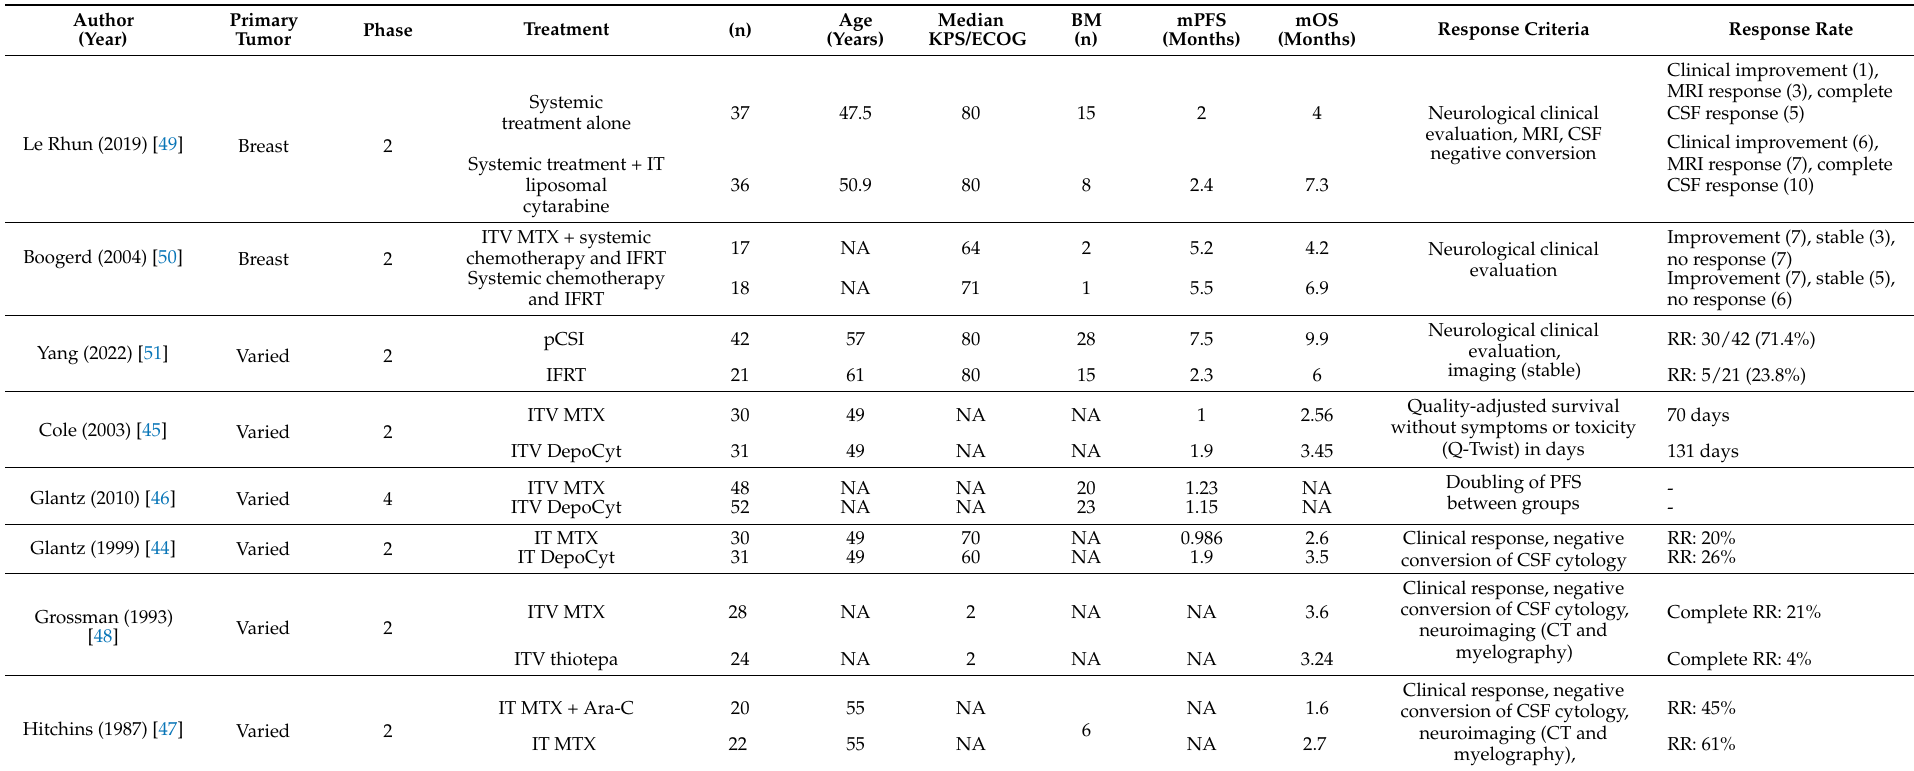
Table 2. Randomized clinical trials for leptomeningeal carcinomatosis from solid non-hematological